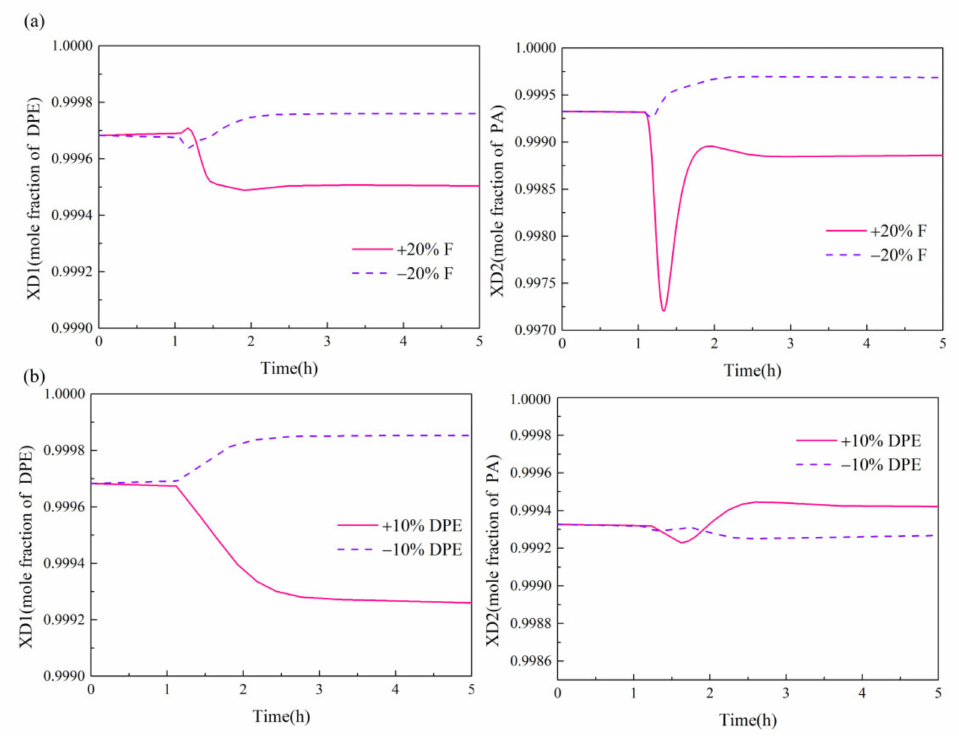
Figure 14. Dynamic responses of CS2 ( a ) 20% feed flow rate disturbances, ( b ) 10% feed composition